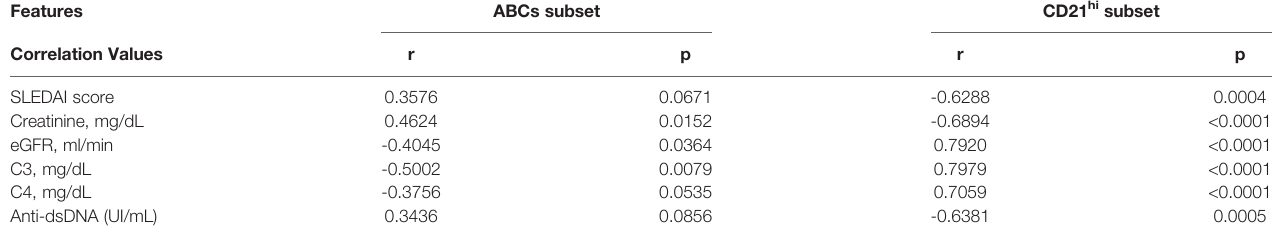
TABLE 2 | Correlations between ABCs or CD21 hi cell frequencies with clinical/laboratory features of SLE/LN patients. Features